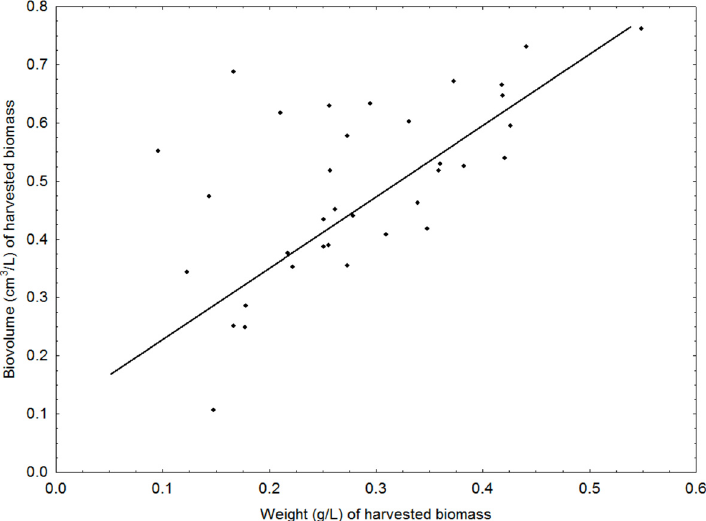
Figure 15. Harvested biovolume from the 300,000 L reactor vs. wet weight of the same harvested biomass, r = 0.61 at p < 0.05 and n = 60. Table 6. Operating results from cultivation in the 300,000 L reactor 2018–2021. Mean +/ − S.D.